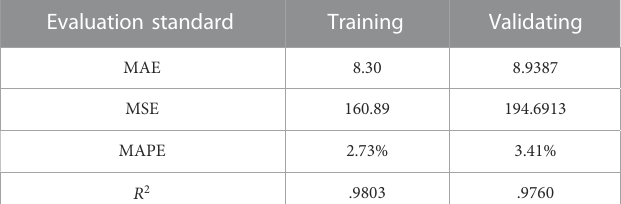
TABLE 2 Evaluation standard.